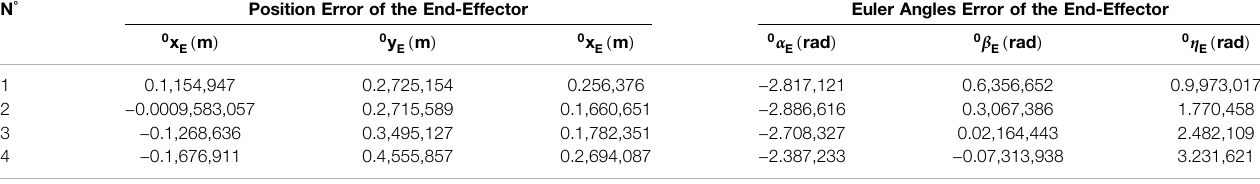
TABLE 3 | Position and orientation angle of the end-effector corresponding to the given impact point. N ° Position Error of the End-Effector